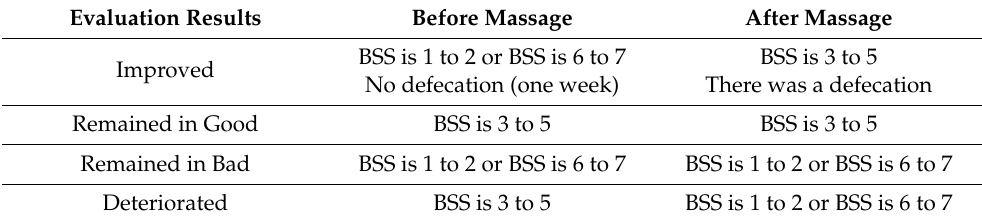
Table 1. Method of comparison of changes in Bristol Stool Scale (BSS) before and after massage.